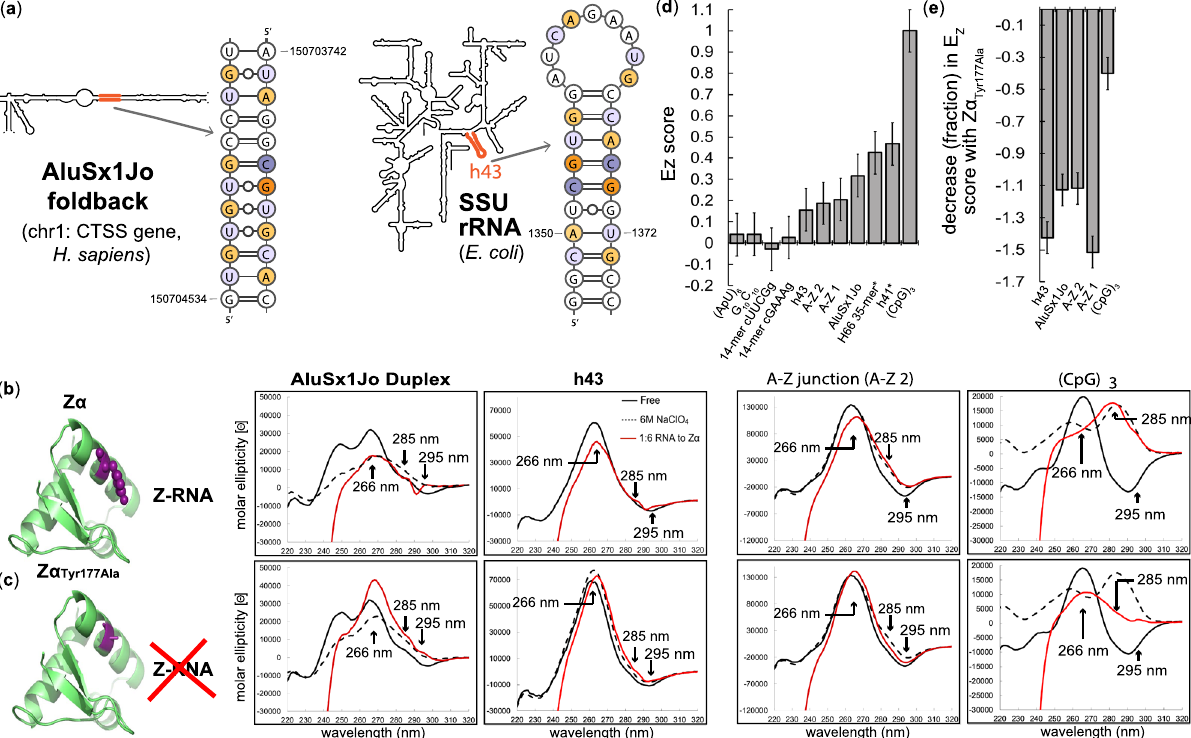
Fig. 2 Z α induces a partial Z-conformation in AluSx1Jo and h43. a Location of AluSx1Jo and h43 on secondary structure diagrams of the CTSS gene (Chromosome 1) from H. sapiens and the small subunit ribosomal RNA from E. coli . For h43, the fi rst three G = C base pairs were engineered for added stability. In this and subsequent fi gures, CpG and YpR steps are shown in dark (CpG) and light (non-CpG YpR) shades of purple/orange colors. b CD spectra of the AluSx1Jo and h43 RNAs in absence of protein (black) and at the 1:6 RNA:Z α ratio (red), at which binding is saturated. Controls: 6 M NaClO 4 (dotted line), ionic condition that promotes Z-RNA formation of CpG repeats 57 ; A-Z junction 35 (second to right-most panel), which is an RNA that has a (CpG) 6 sequence followed by an A-RNA forming sequence, and (CpG) 3 (right-most panel), which is fully converted to Z-RNA at a 1:2 RNA:Z α ratio. c Same as b , but with Z α Tyr177Ala instead of wild-type Z α . d E Z scores quantifying the extent of Z-conformation for the following fragments: (ApU) 6 , G 10 C 10 , 14mer cUUCGg, cGAAAg tetraloop (negative controls); h43 from E. coli ; AluSx1Jo; H66 35mer from H. sapiens ; (CpG) 3 (positive control). e Reduction in E Z score for AluSx1Jo, h43, and (CpG)3 RNAs (expressed as a fraction) when Z α Tyr177Ala is used instead of Z α . * indicates that RNA forms a duplex as determined by AUC when stem-loop was expected (Supplementary Fig. 5). An error of 0.1 was determined to be appropriate for the calculated E Z scores by taking into account the difference between the (CpG) 3 and (CpG) 6 RNAs (which theoretically both have an E Z score of 1) and the difference in the E Z score between repeat measurements on h43 E.coli . All other E Z scores were determined from one CD